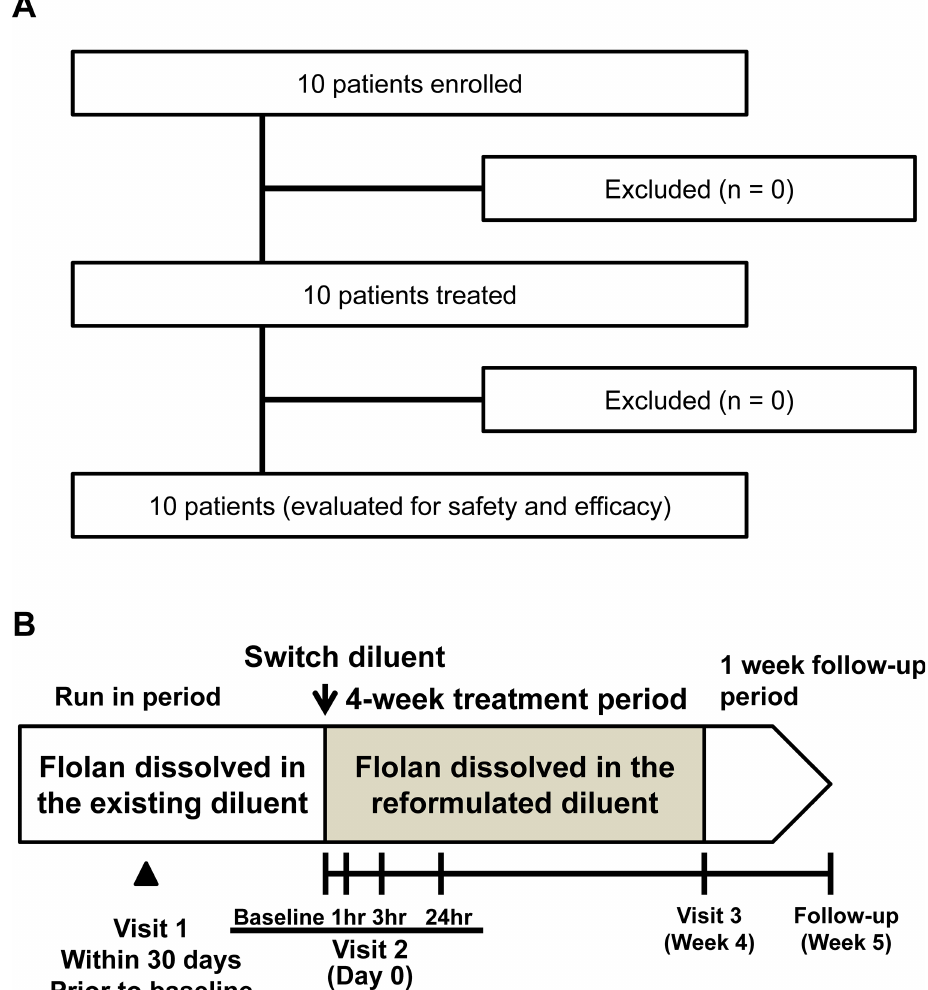
Fig 1. Patient disposition and study design. (A) Patient disposition: Ten patients were enrolled and entered the study during the run-in period. All patients completed the treatment and follow-up periods. (B) Study design: The study consisted of 3 periods: 1) a run-in period when patients were treated with the Flolan solution prepared with the existing diluent for up to 30 days, 2) a 4-week treatment period with the new Flolan solution prepared with the reformulated diluent, and 3) a 1-week follow-up period. The patients were continuously treated the new Flolan solution prepared with the reformulated diluent during the follow-up